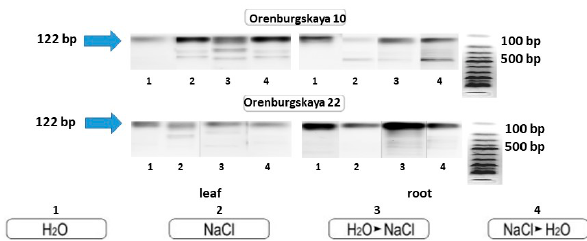
Figure 10. PCR amplification of wheat DNA from leaves and roots with primers for the MnSOD